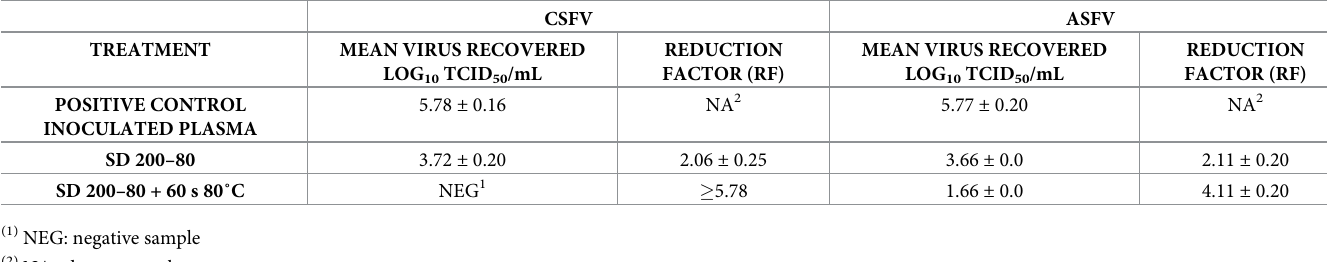
Table 1. Titration of CSFV and ASFV samples before and after the spray drying treatment (Mean ± SD).